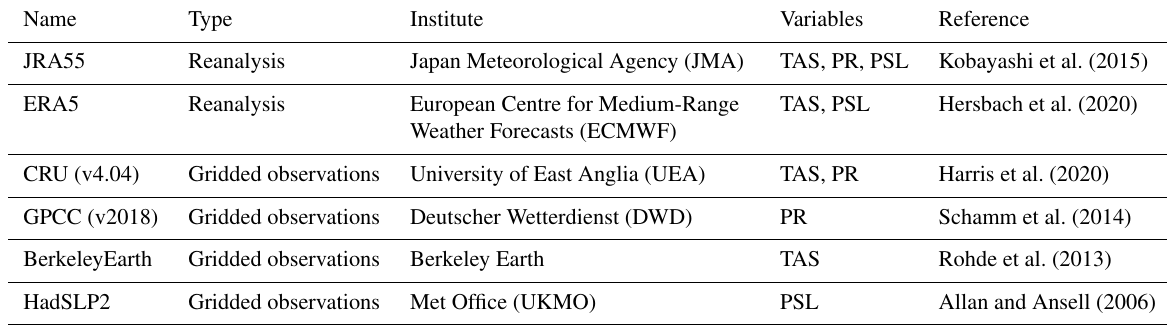
Table 1. Summary of the observational references for near-surface air temperature (TAS), precipitation rate (PR) and sea-level pressure (PSL).